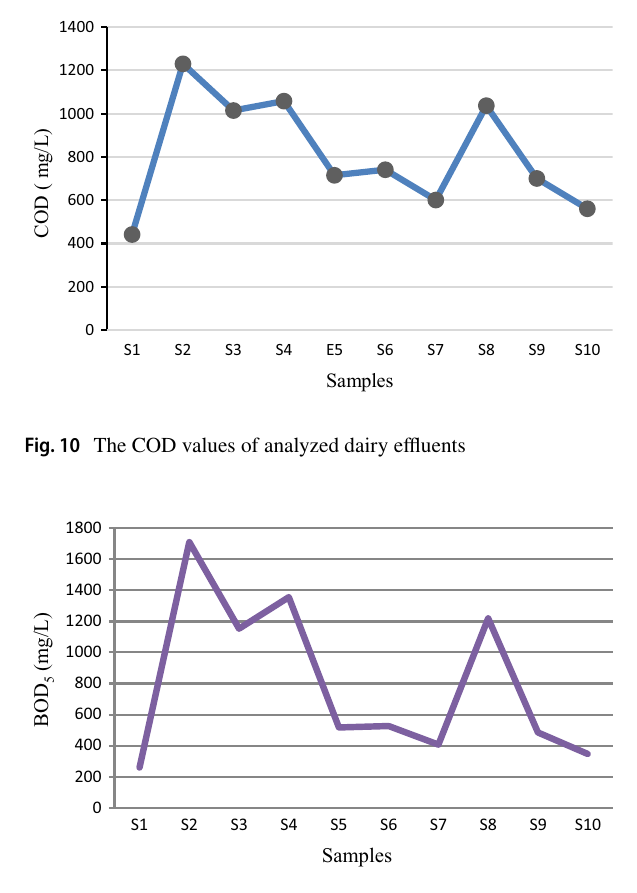
Fig. 11 The BOD 5 values of analyzed dairy